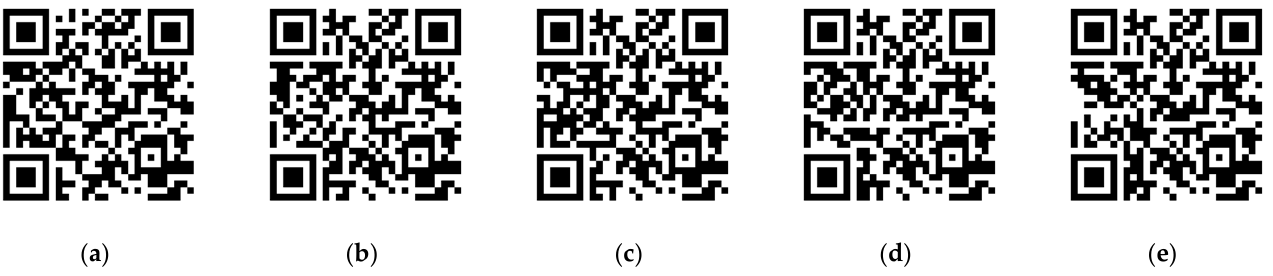
Figure 11. QR codes for direct elevator call and web interface launching from: ( a ) basement; ( b ) ground floor; ( c ) first floor; ( d ) second floor; ( e ) third floor. Web addresses are only accessible in the